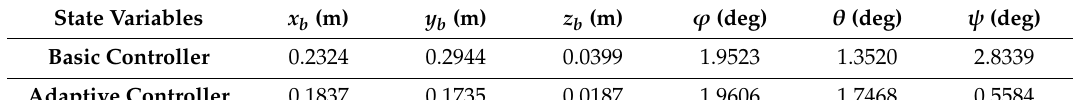
Figure 14. System responses in Scenario 2. Table 4. RMSE of Scenario 2.